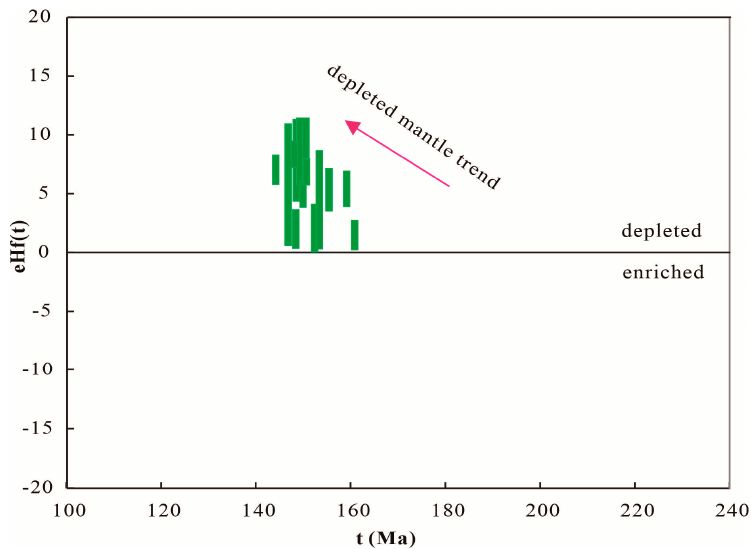
Figure 8. Plots of zircon Hf isotopic compositions versus ages of Late Jurassic igneous rocks in the Erguna Massif. Data sources are listed in Table S3.